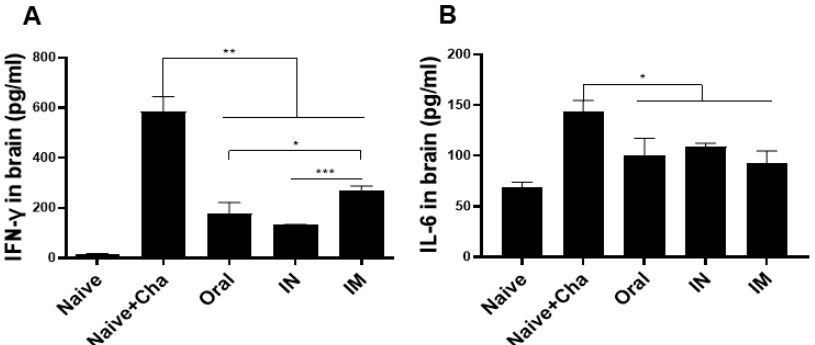
Figure 6. Brain tissues were collected from mice at 35 dpi with T. gondii ME49. The pro-inflammatory cytokines IFN- γ ( A ) and IL-6 ( B ) were measured from brain supernatants. Data are presented as mean ± SD and asterisks indicate statistical differences between groups. (* p < 0.1, ** p < 0.01, *** p < 0.001). All samples were acquired on an individual basis and a total of three independent experiments were performed in triplicates.